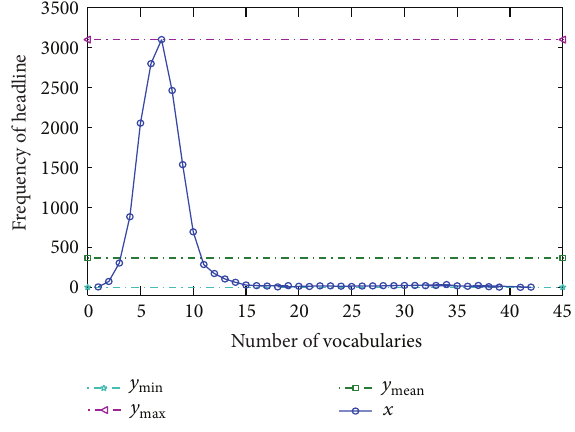
Figure 7: Relationship between number of vocabularies and fre- quency of news headline.